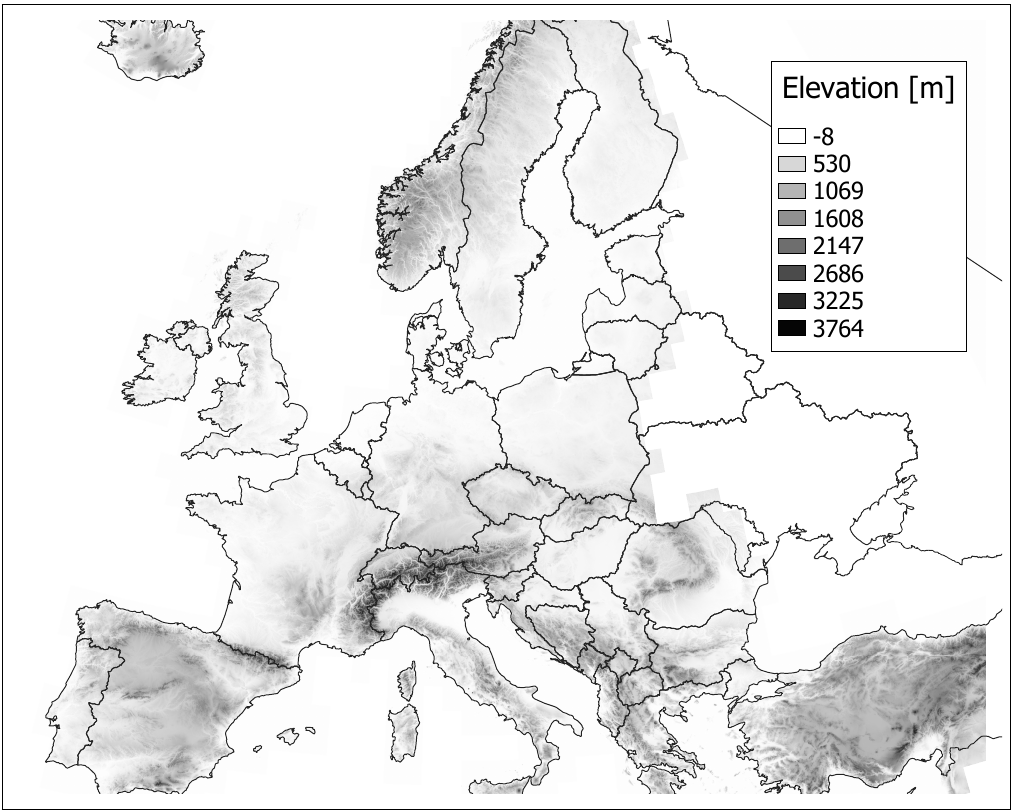
Figure 2. Geographical coverage of elevation data in Europe. Own illustration based on